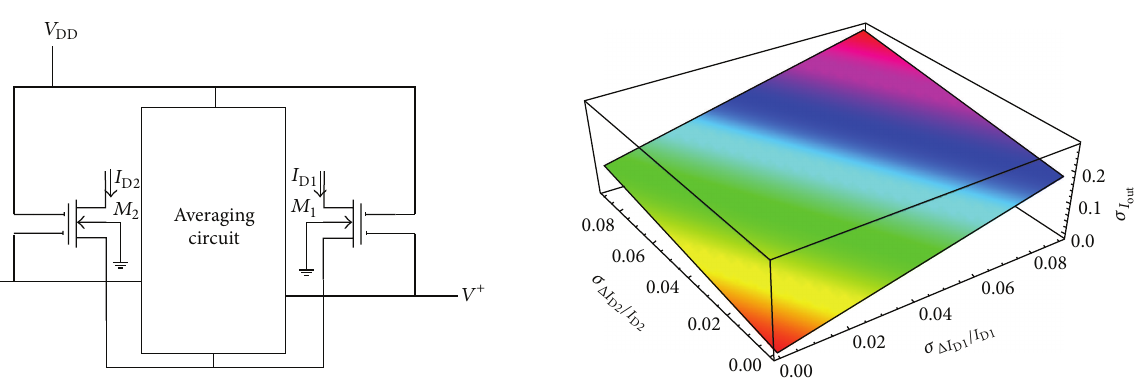
Figure 6: The 3D plot 𝜎 Δ𝐼 of the subthreshold FGMOSFET based out and 𝜎 Δ𝐼 OTA versus 𝜎 Δ𝐼 𝐷1 /𝐼 𝐷1 𝐷2 /𝐼 𝐷2